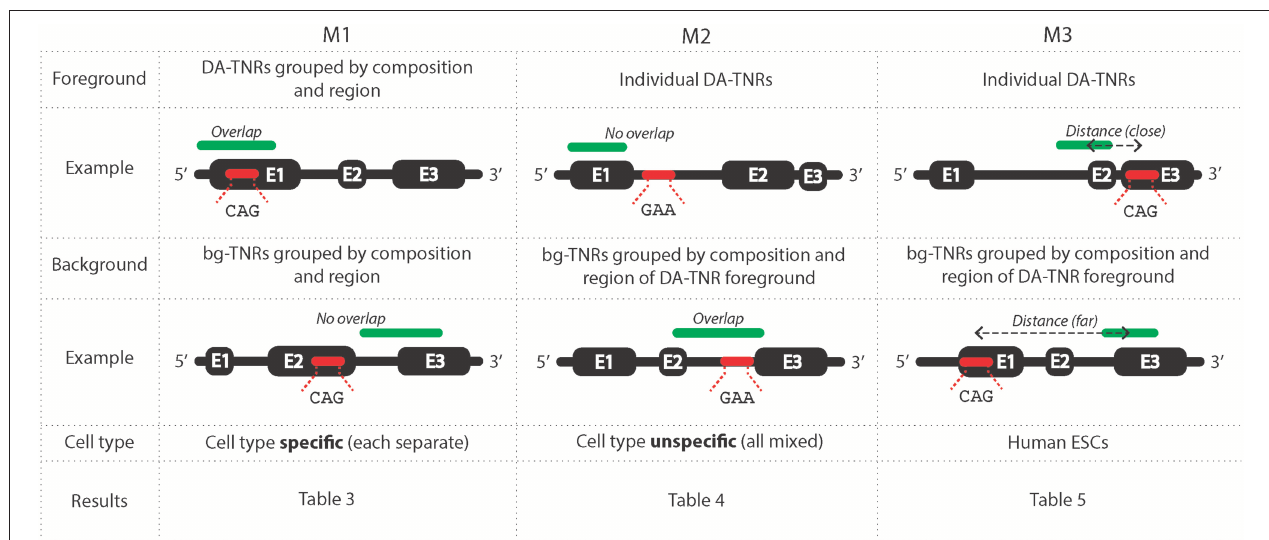
FIGURE 1 | A graphical representation of the three methods used to measure an enrichment of epigenetic environment around DA-TNRs. M1 measures an association between a group of DA-TNRs and an epigenetic mark on basis of overlap within each cell type. M2 measures an association between a specific DA-TNR and an epigenetic mark on basis of their overlap when cell type is ignored. M3 uses a distance from the centre of the repeat to the centre of the epigenetic mark to measure enrichment. Each method makes different use of assays from available cell types, foregrounds and statistical tests to measure